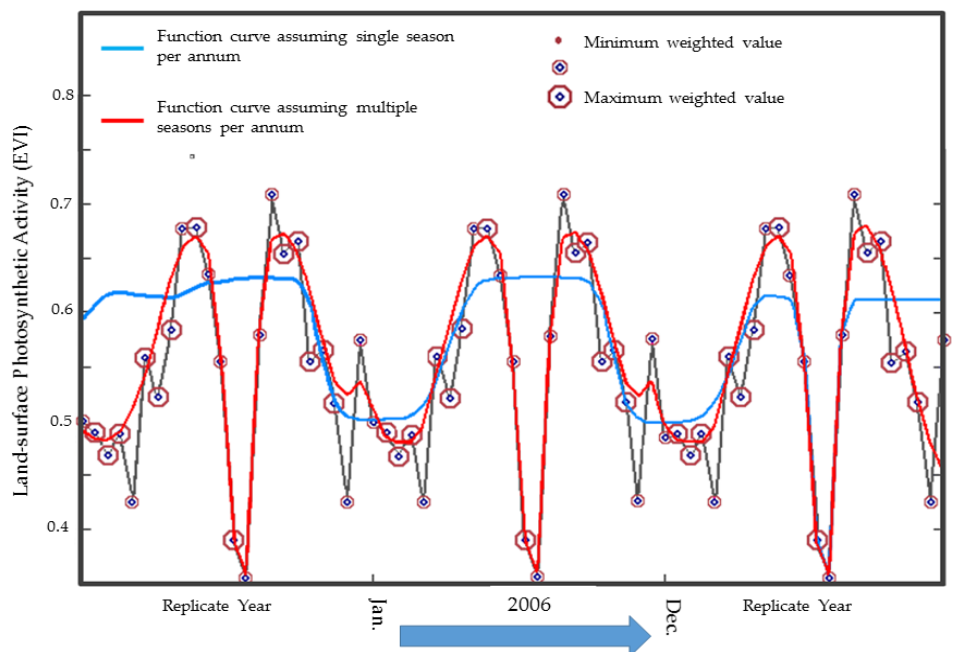
Figure 7. Impact of inappropriate model selection on obtaining optimal seasonality profiles for an area of Ireland’s photosynthetic activity. Both a single season (blue) and double season (red) Gaussian curve have been fit to a single-year time-series of MODIS enhanced vegetation index data for 2006, with replicates for the years before and after. The presence of a mid-season decrease in photosynthetic activity (potentially linked to intensive field management activities) is obscured by the application of a single-season curve. The conclusions of the modelling shown here are reported in [112].